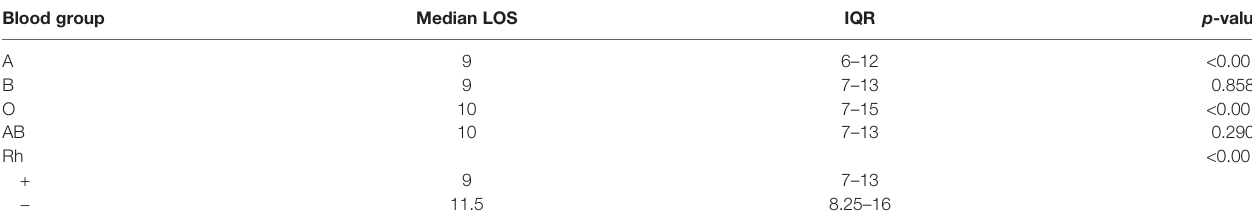
TABLE 3 | Comparison of ABO and Rh blood groups distribution and recovery period (LOS) of patients with COVID-19 infection. Blood group Median